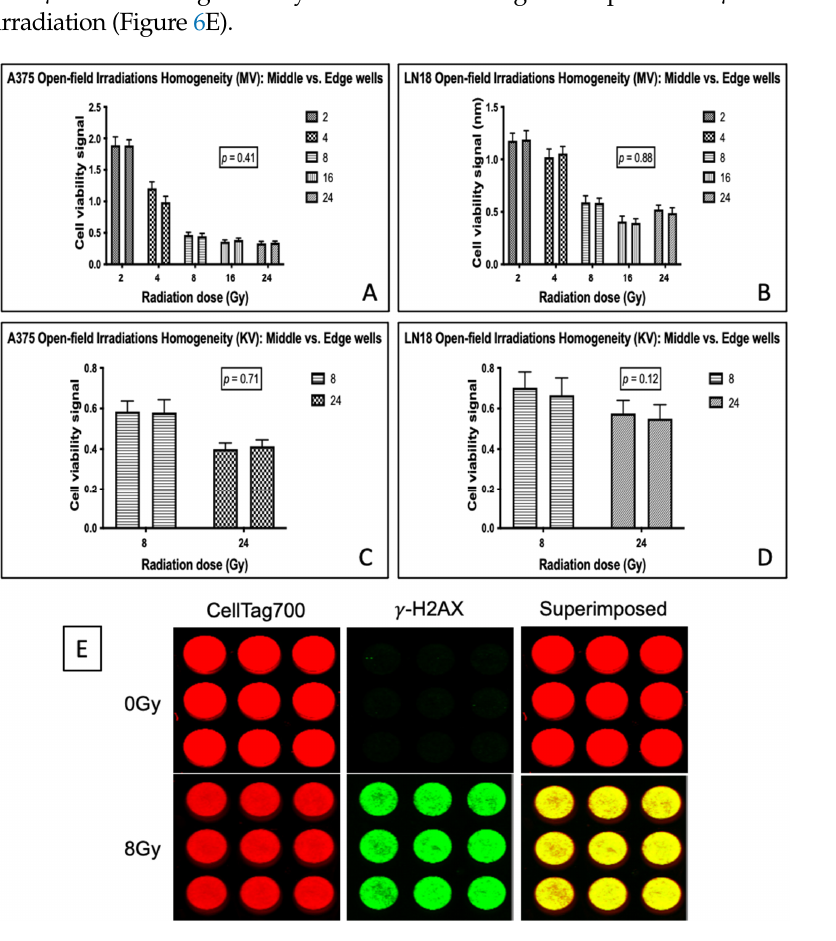
Figure 6. ( A – D ) Comparison of cell viability signal between central and edge wells showing no significant differences. ( A,B ) MV irradiations, p = 0.41 for A375 cell line and p = 0.88 for LN18 cell line. ( C,D ) KV irradiations, p = 0.71 for A375 and p = 0.12 for LN18. ( E ) Homogeneous distribution of γ -H2AX foci (in green) for A375 cell line. CellTag700 stain (in red) was used to stain nucleus and cytoplasm. Superimposed images showing homogeneous γ -H2AX foci distribution related to cells (in yellow). Radiation doses are in Gy. Cell viability signal measured at 490 nm. Error bars indicate standard deviation.